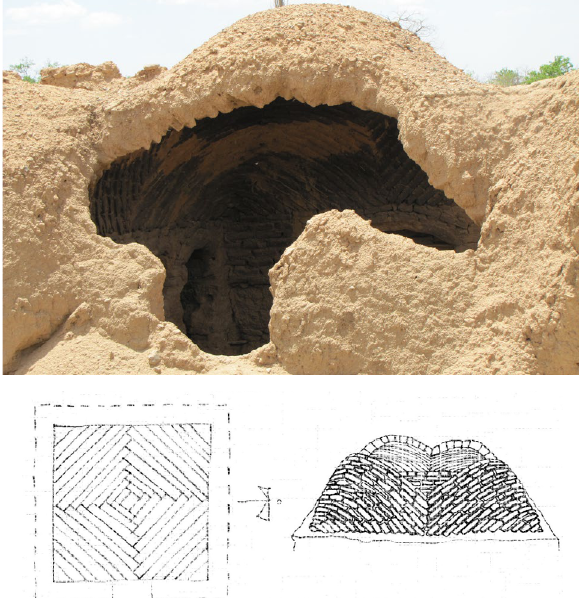
Figure 6. Chahar-dori vault executed in a livestock space, author.